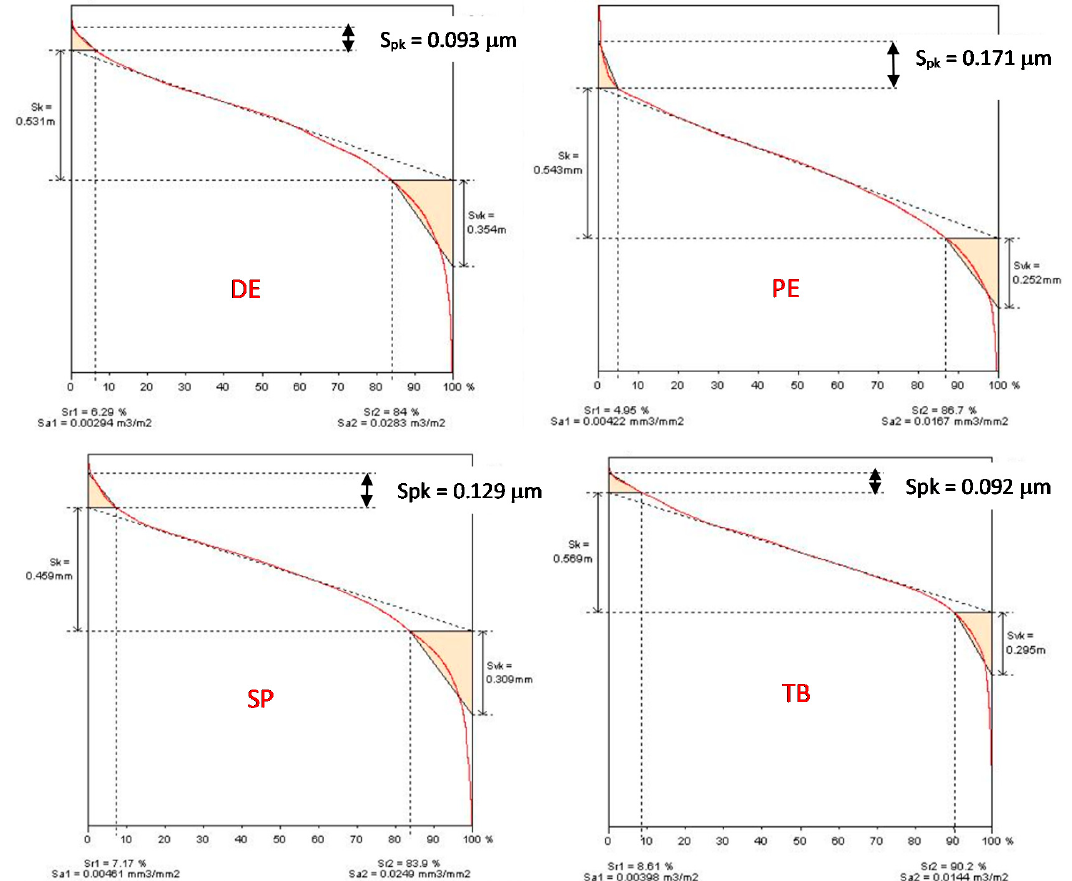
Figure 5. Abott-Firestone curves of worn discs. Metals 2020 , 10 , x FOR PEER REVIEW